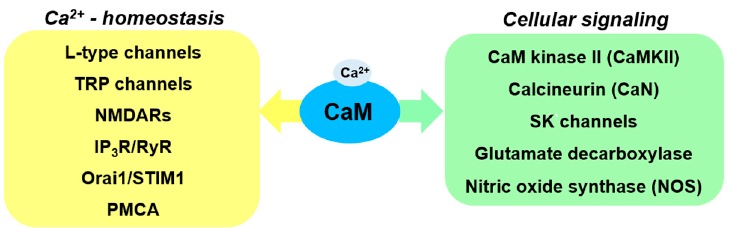
Figure 1. Selected calmodulin (CaM) targets involved in regulation of Ca 2+ -homeostasis and cellular signaling with potential role in Parkinson’s disease (PD).